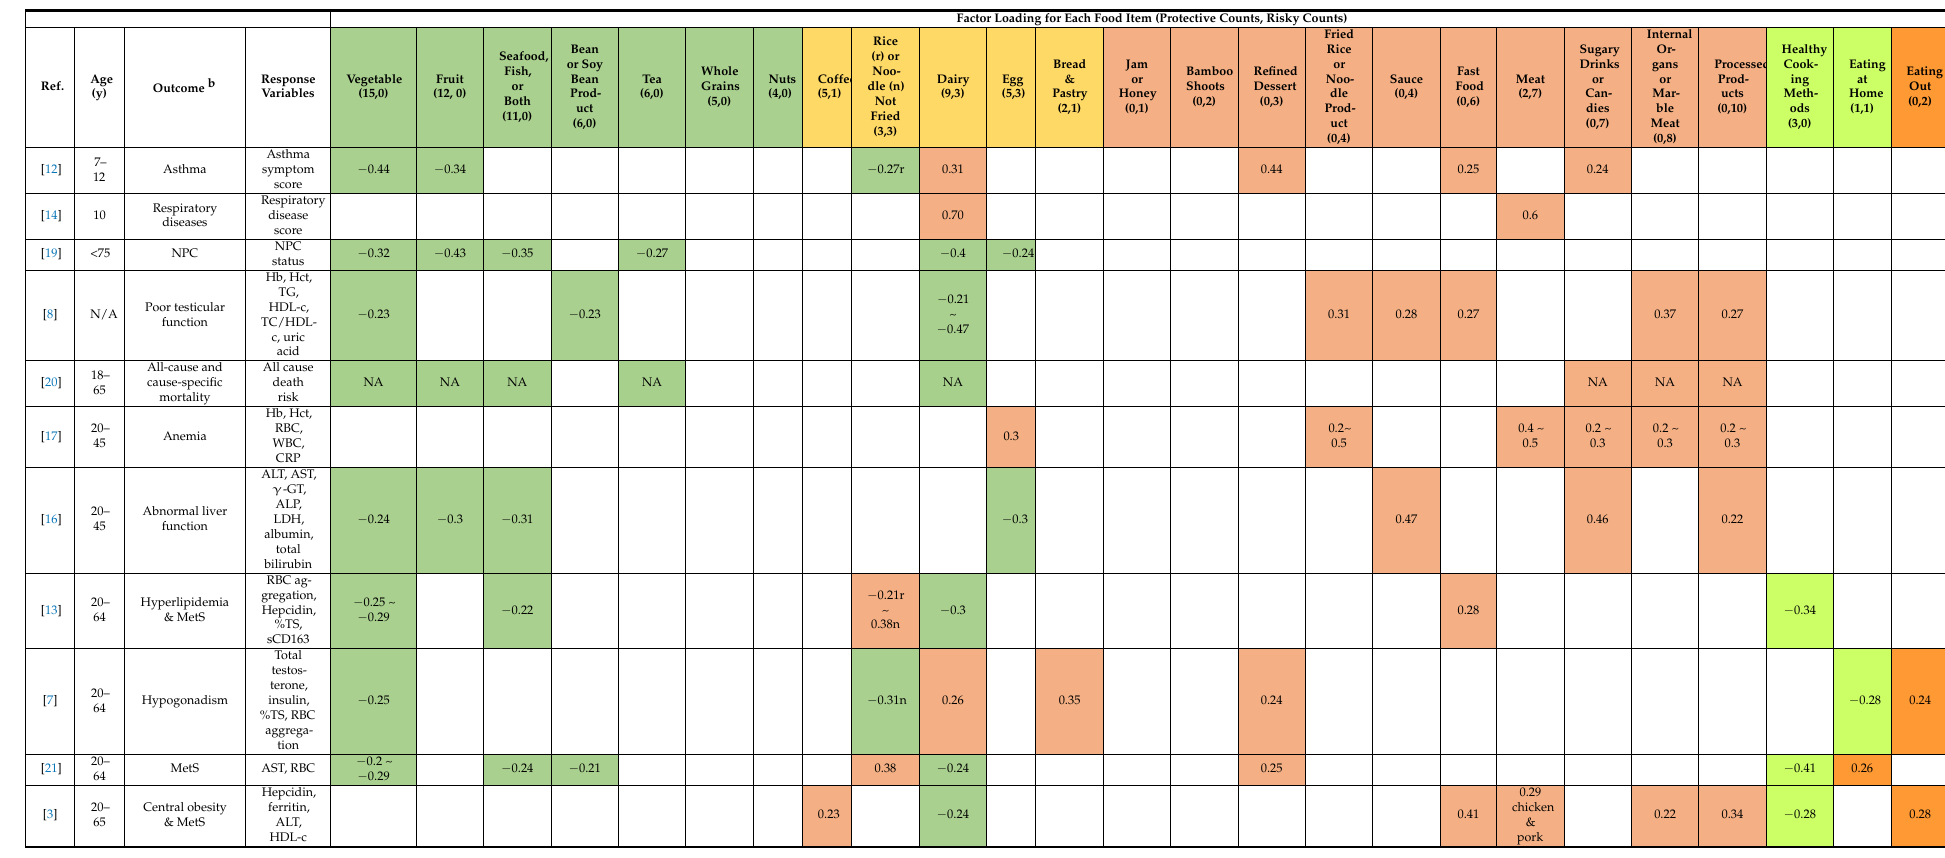
Table 2. Food items identified as inversely, positively, and bidirectionally associated with disease-associated biomarkers and outcomes including mortality in 19 discovery dietary pattern studies a